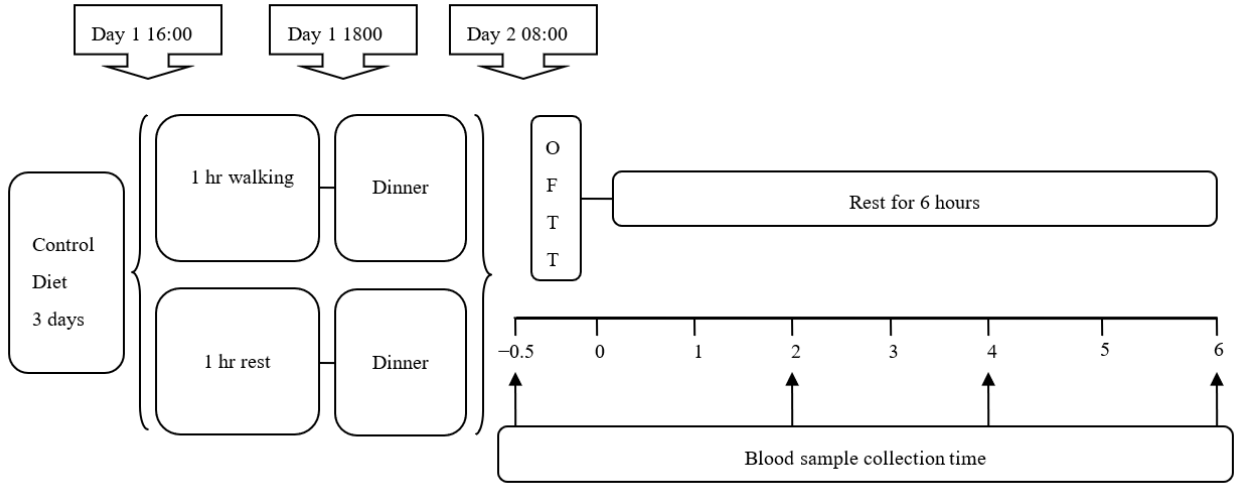
Figure 1. Study design. Subjects completed two experimental trials: endurance exercise trial (EE), the subjects completed the endurance exercise of 1-h 50% VO 2 max walking in the afternoon of the first day of the experiment; in the control trial, subjects were rested. On the next morning of the experiment, the subjects were given a high-fat meal and a blood sample was collected ( ↑ ). OFTT: oral fat tolerance test.